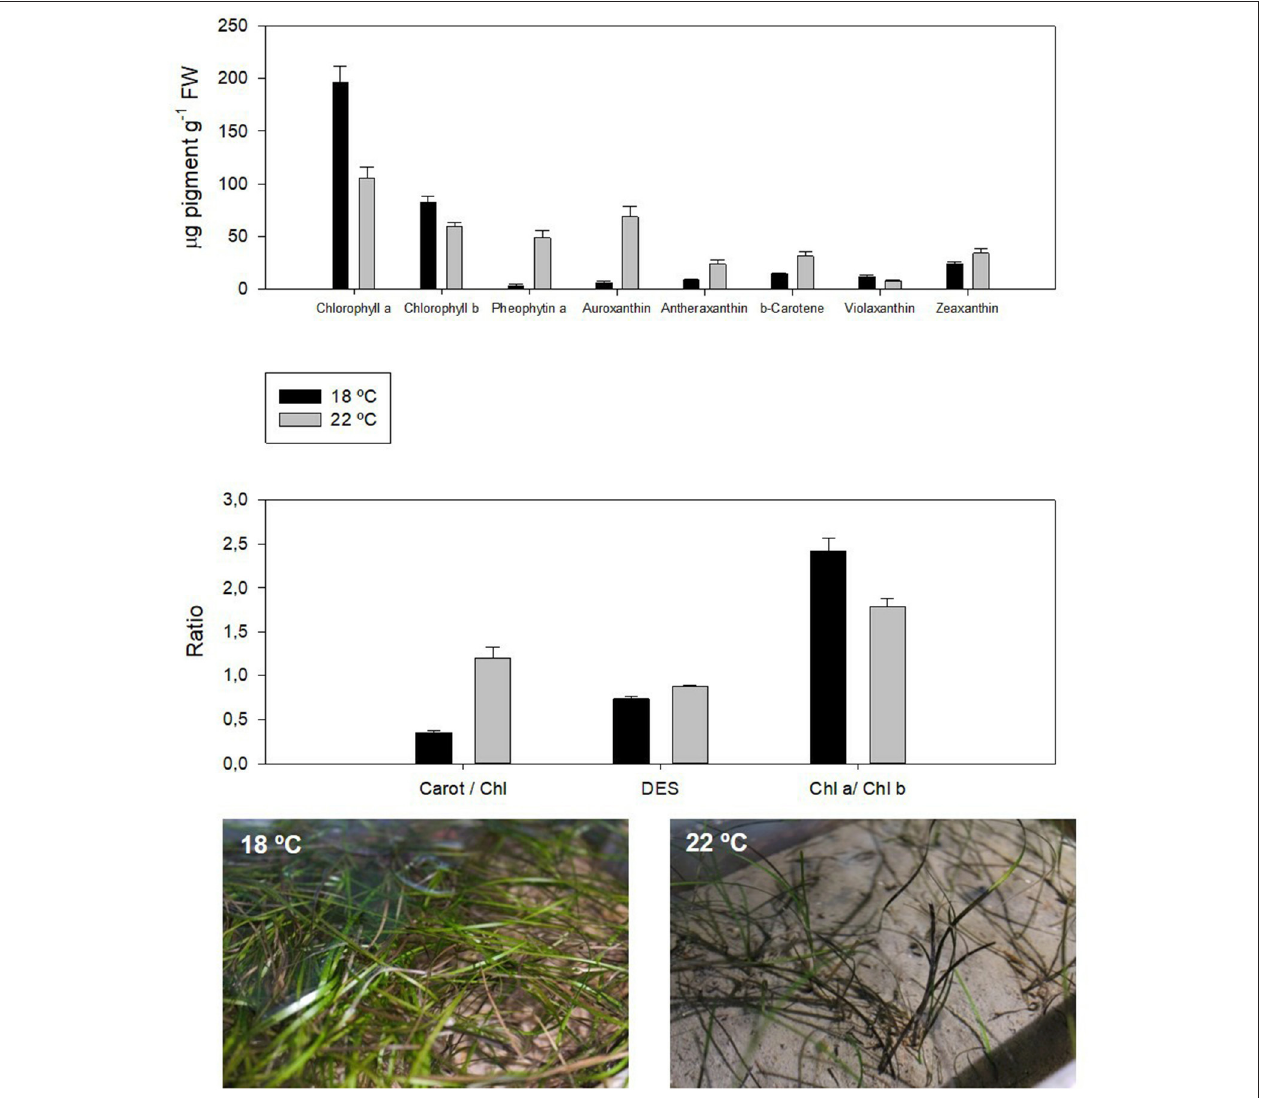
FIGURE 2 | Pigment profile in the dwarf eelgrass (Zostera noltii) under control and ocean warming conditions. The decrease in chlorophylls and increase in carotenoid content as well as chlorophyll degradation products are symptoms of thermal stress, concomitant with the decrease in the chl a/chl b ratio, a well-known indicator of stress (adapted from Repolho et al.,